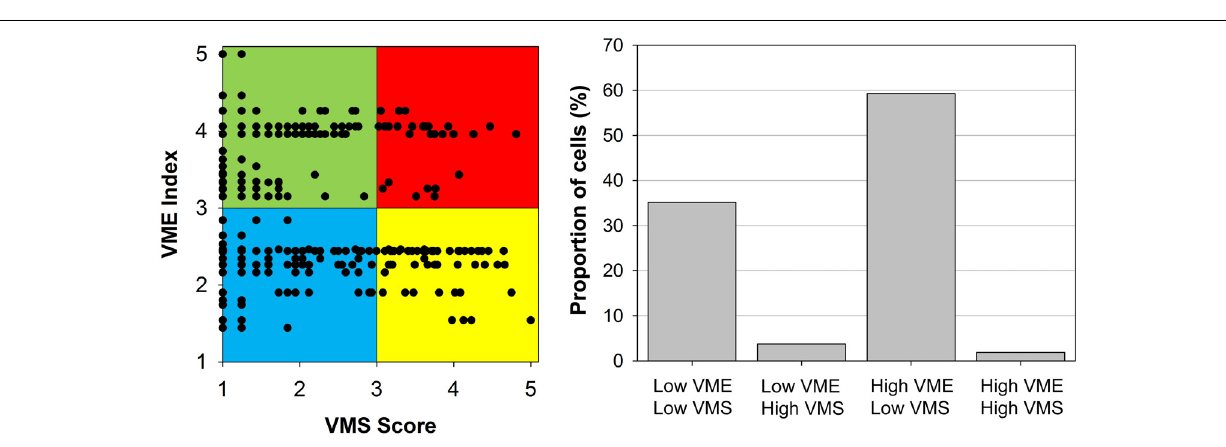
FIGURE 7 | Application of the portfolio categories concept to the ICES database. In the left panel, the different colors represent four portfolio categories: blue is low VME – low VMS, yellow is low VME – high VMS, green is high VME – low VMS, and red is high VME – high VMS. In the right panel, proportions of cells falling into those categories are